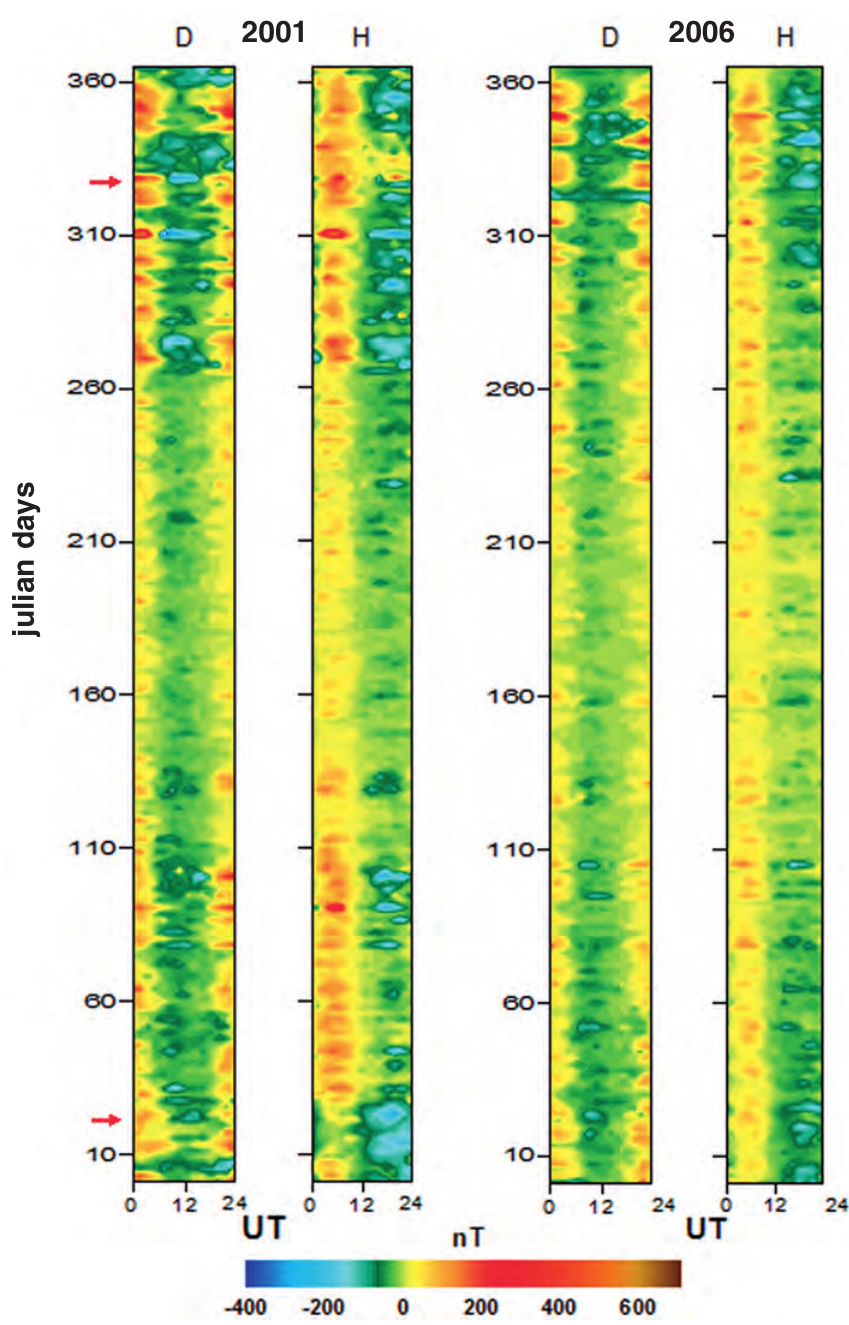
Fig. 5. Dynamic maps of diurnal variation for D and H components for 2001 and 2006